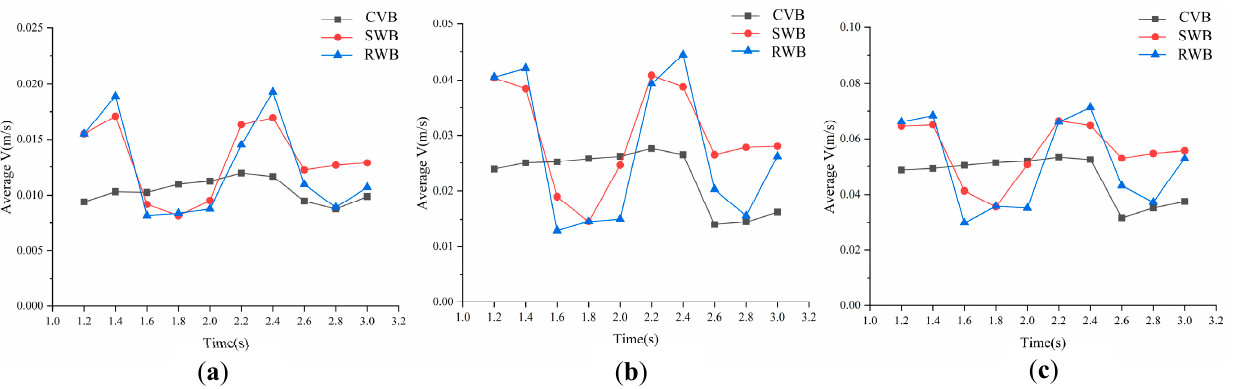
Figure 13. Variable–velocity blowing wave–design diagram: ( a ) Sine–wave blowing system SWB; ( b ) Rectangular–wave blowing system RWB.